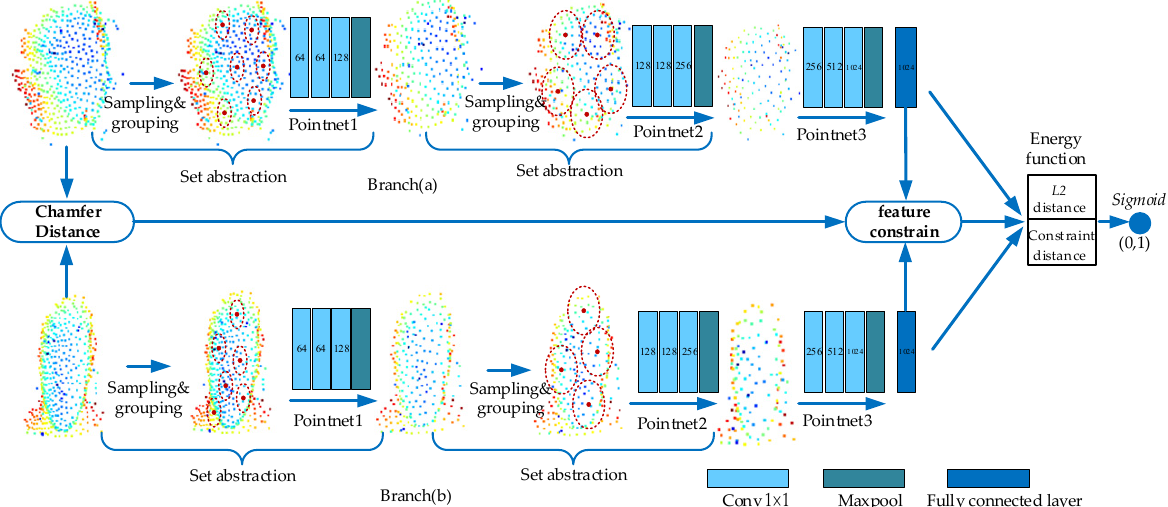
Figure 5. The whole structure of our method. Two identical branches are adopted to extract features separately, and the chamfer distance is used to constrain original point clouds. At the end of the network, a novel energy function is introduced to distinguish the similarity of objects.